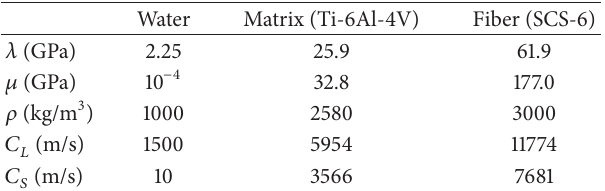
Table 1: Basic properties for material